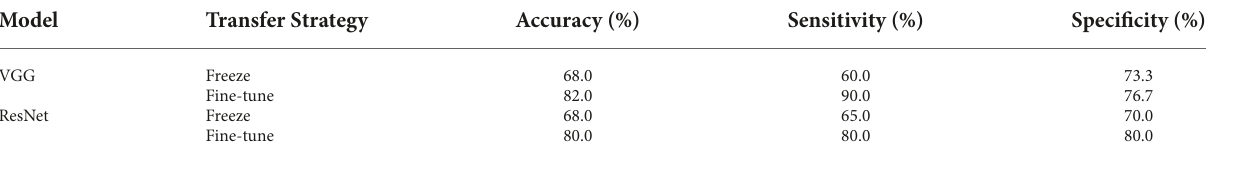
TABLE 5 The influence of different transfer strategies on the VGG and ResNet